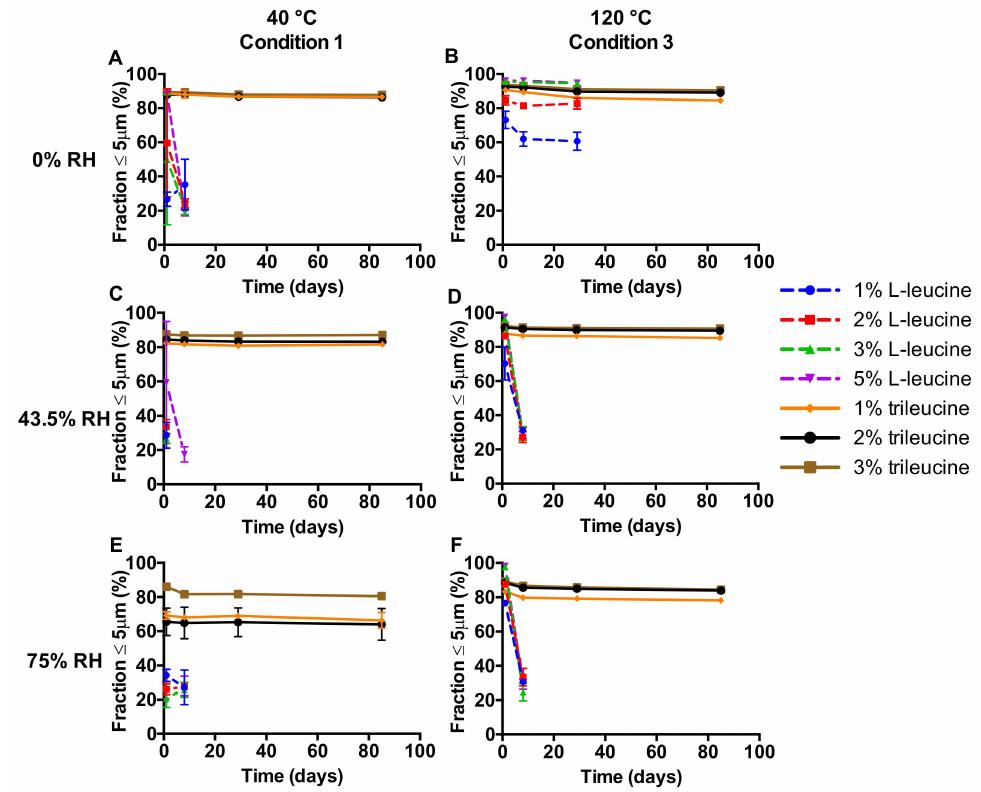
Figure 2. The fraction ≤ 5 µ m of the primary particle size distributions at di ff erent storage relative humidity (RH) values over time ( n = 6, average ± SD). Isoniazid formulations were spray-dried at two di ff erent inlet temperatures. Storage RH values are displayed on the left-hand side and spray-drying inlet temperatures on